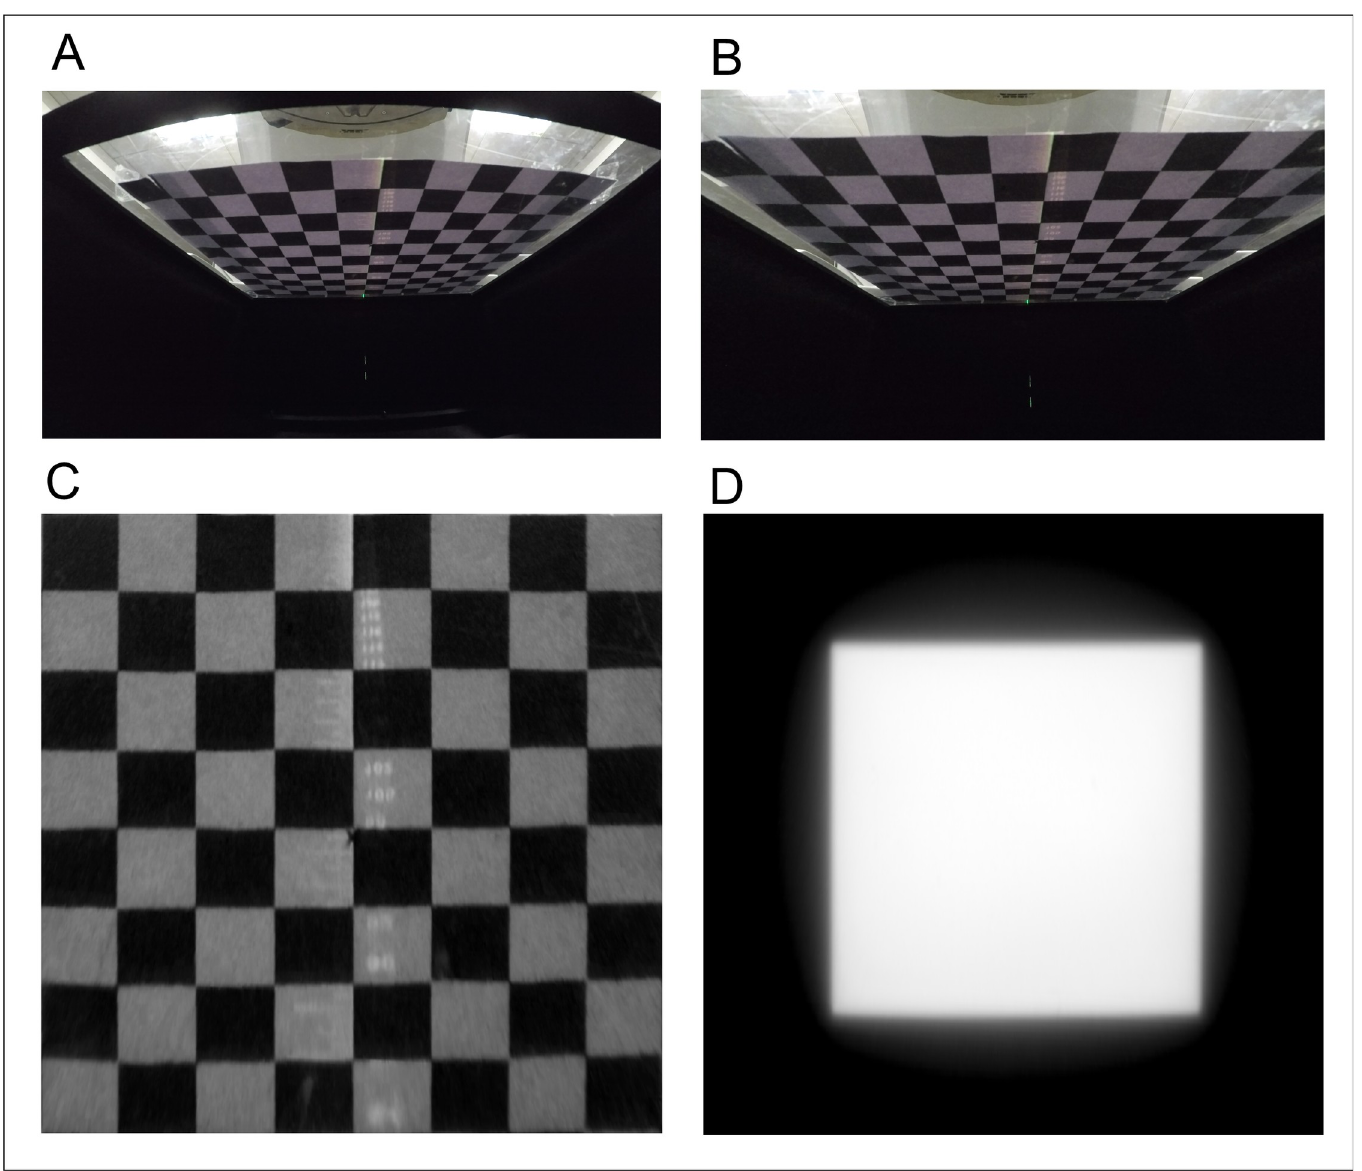
Fig 5. Procedure for geometric correction: (A) Original image, (B) image after lens correction, (C) image after perspective correction, and (D) two-dimensional scintillation distribution of the 10.0 × 10.0 cm 2 field after geometric correction.